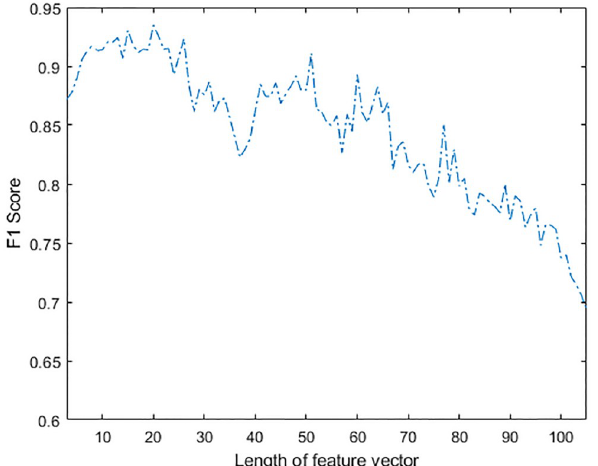
Fig 6. Effect of feature vector length on F1 Score of